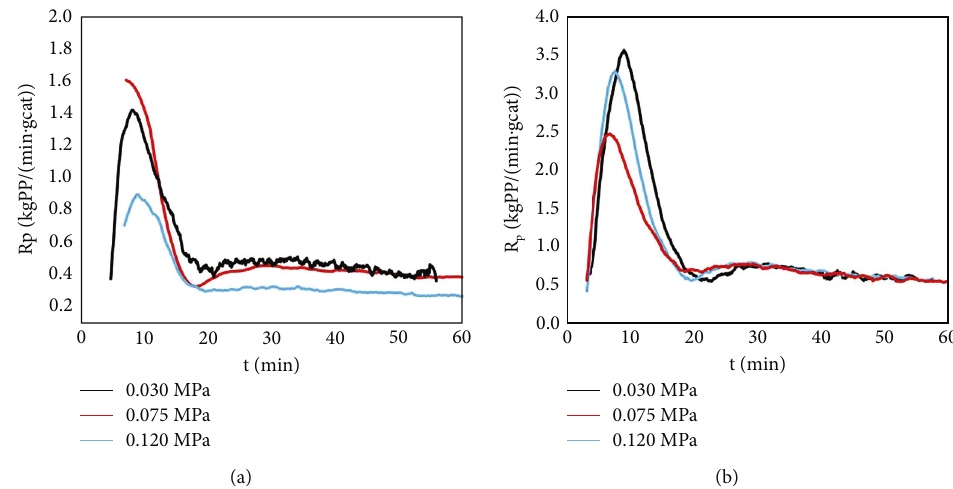
Figure 7: Polymerization kinetic curves at di ff erent hydrogen pressure at 70 ° C: (a) type C catalyst injection and (b) type A catalyst injection.